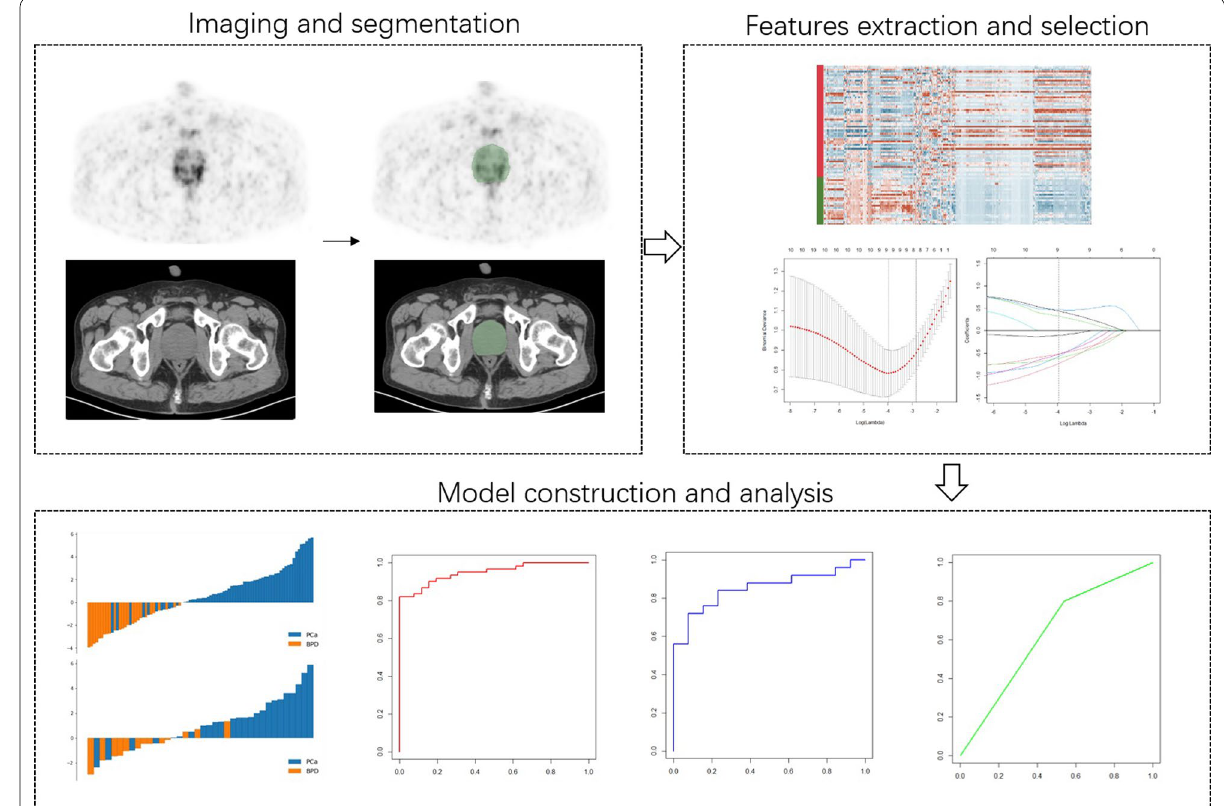
Fig. 1 Radiomics modeling and analysis